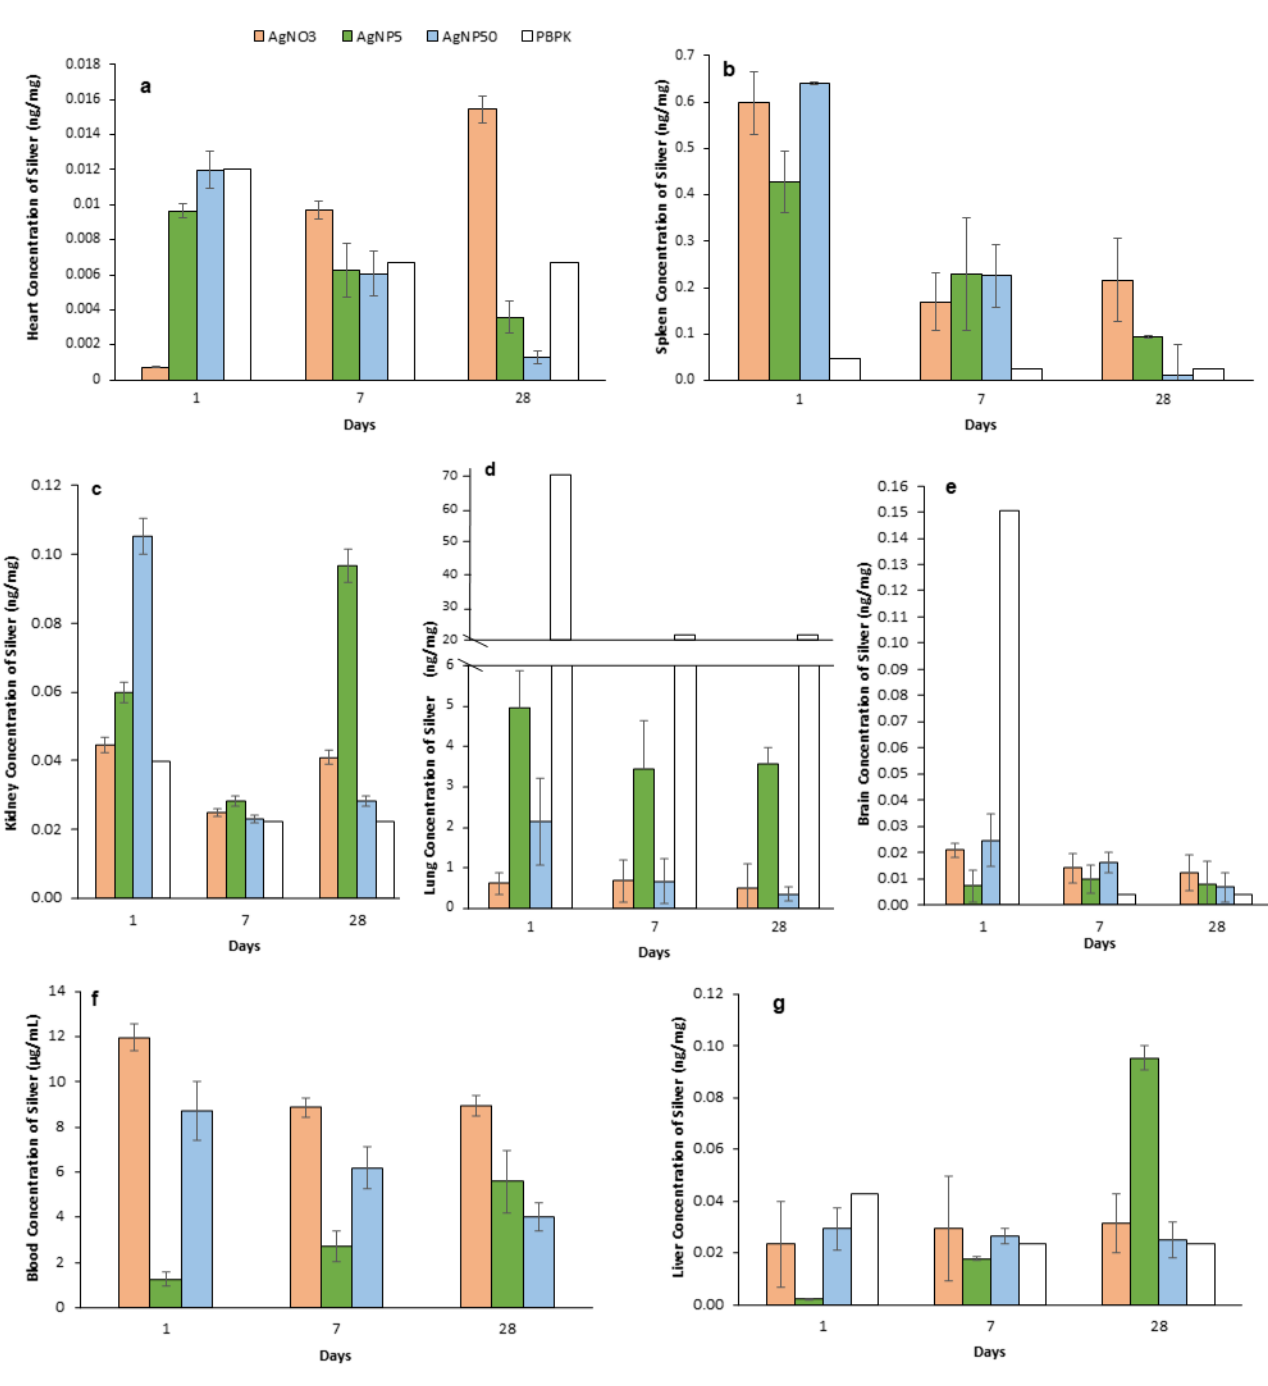
Figure 7. Silver concentrations (ng/mg tissue fresh weight) during a 28-day recovery time after repeated intratracheal instillations of saline (control), AgNO 3 , AgNP5 and AgNP50. ( a ) Heart; ( b ) spleen; ( c ) kidney; ( d ) lung; ( e ) brain; ( f ) blood; ( g ) liver. Silver PBPK data are represented as the lighter bars ( n = 4).